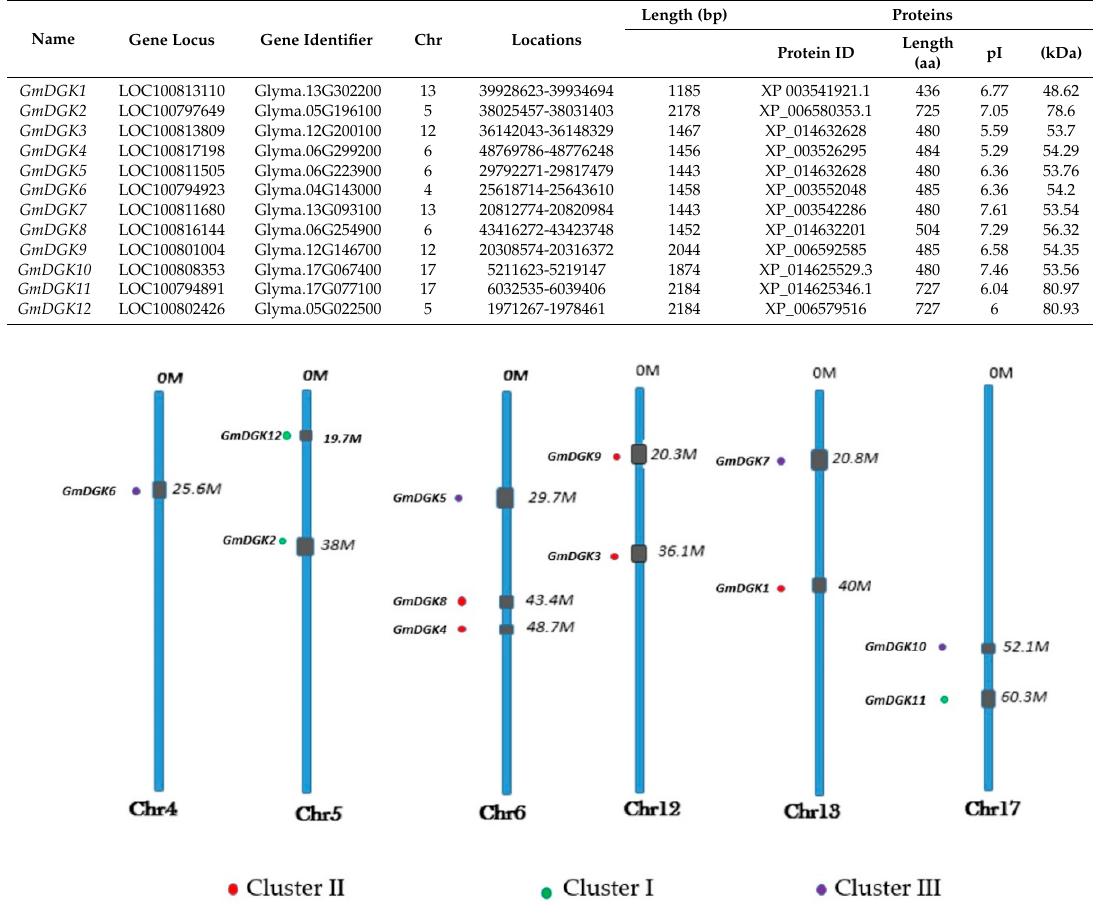
Table 1. Characterization of the soybean ( Glycine Max ) genome data transcript identifiers (IDs) with gene names, gene loci, gene identifiers, chromosomes (Chr), localization coordinates, ORF length (bp), isoelectric point (pI), protein identifiers, protein lengths (amino acids; aa), and protein weights (kDa).